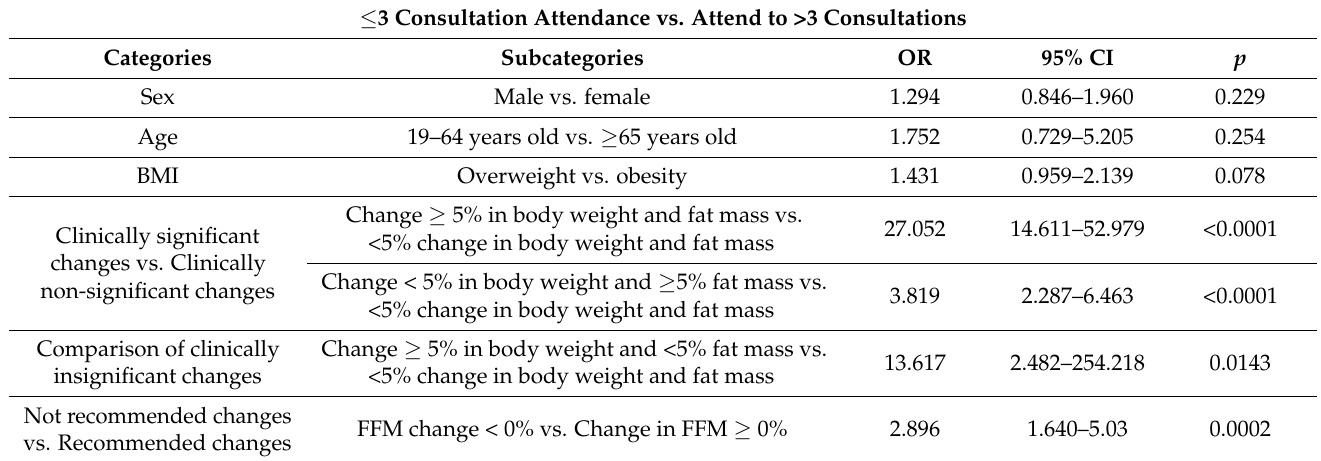
Table 3. Odds ratio (OR) for the risk of consultations by gender, age, BMI, changes in weight, fat mass, and fat-free mass. ≤ 3 Consultation Attendance vs. Attend to >3